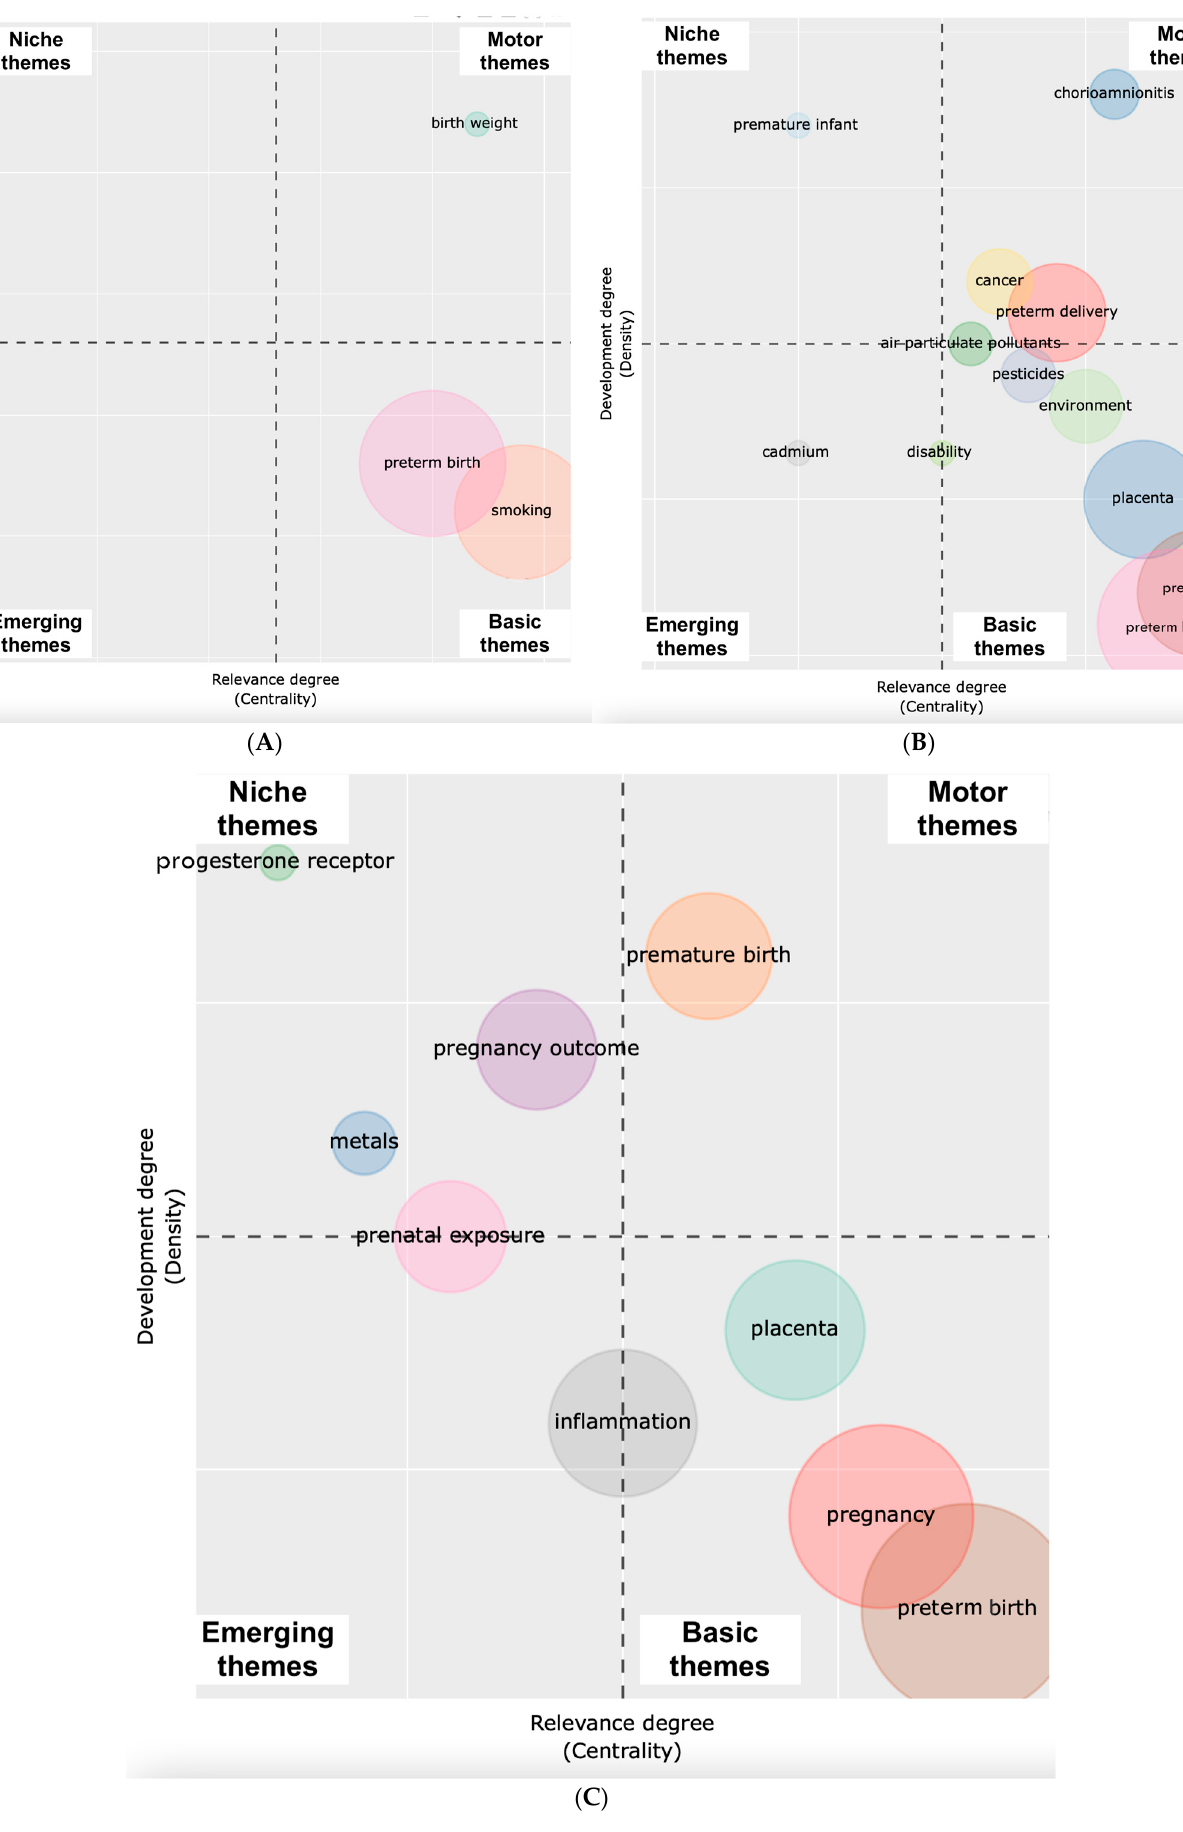
Figure 5. Thematic evolution of author keywords from ( A ) 1973 to 2000, ( B ) 2000–2012, and ( C )